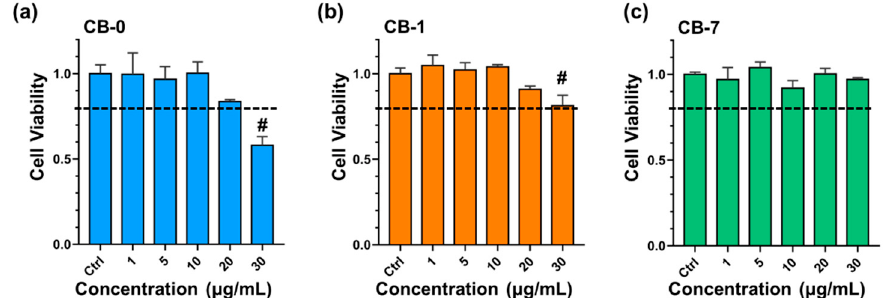
Figure 2. Cytotoxicity of parental and aged CB particles in J774A.1 cells. Cytotoxicity of CB-0 ( a ), CB-1 ( b ), and CB-7 ( c ) in J774A.1 cells after 24 h treatment at various concentrations (n = 6). All controls are untreated groups. Statistical significance between groups: (#) p < 0.001, relative to the untreated control. Abbreviations: CB, carbon black.